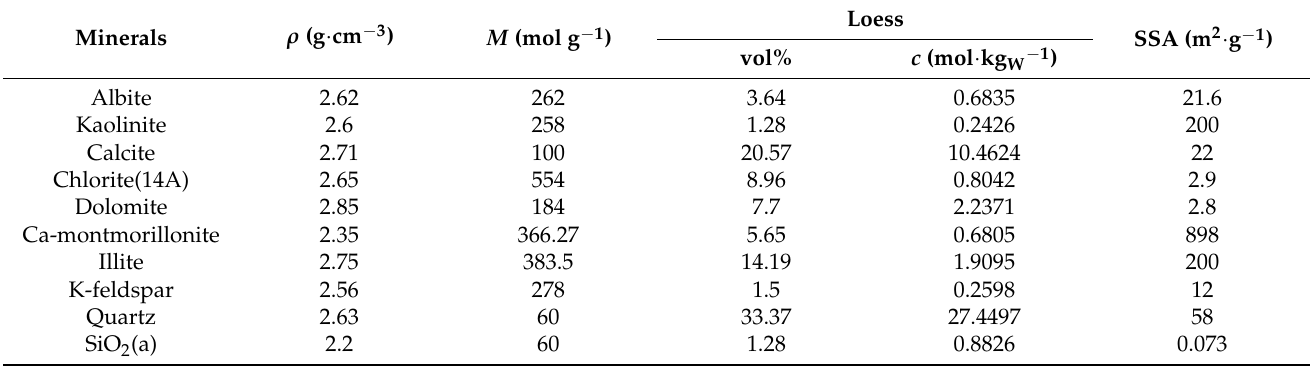
Table 2. Input data of the loess rock composition. SSA: specific surface